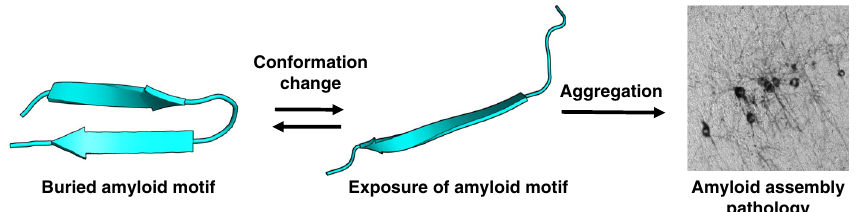
Fig. 8 Molecular model of tau amyloid domain structural rearrangement and subsequent aggregation. Naive tau monomer (left) exists with a propensity to form a relatively collapsed structure, which buries the amyloid domain 306 VQIVYK 311 . In the presence of disease-associated mutations, proline isomerization events, or certain splice isoforms, the equilibrium is shifted to disfavor local compact structure. This exposes the aggregation-prone 306 VQIVYK 311 amyloid motif and enhances aggregation propensity, leading to subsequent tau